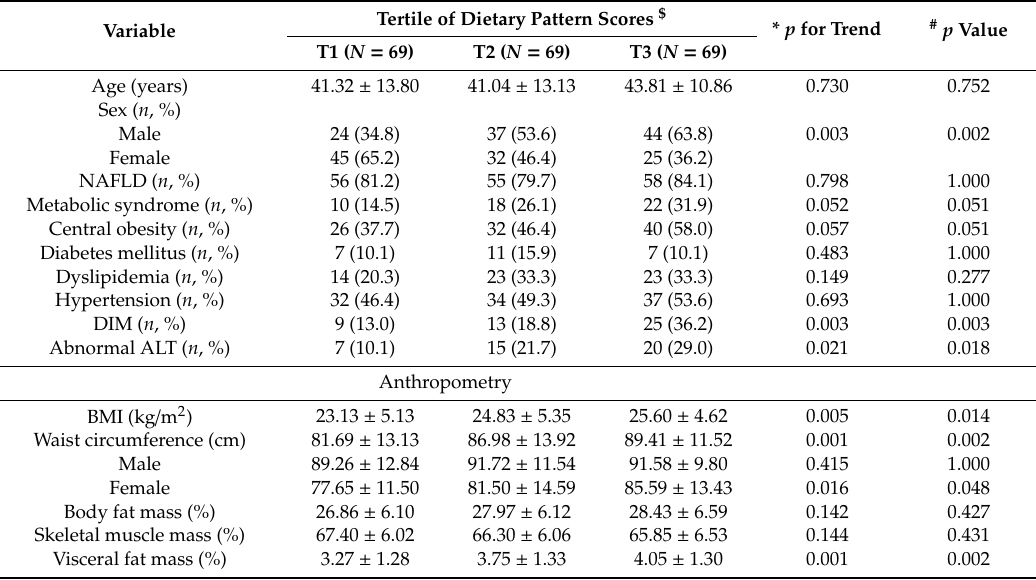
Table 5. Clinical characteristics and blood biochemical levels of the study population stratified by tertiles of dietary pattern